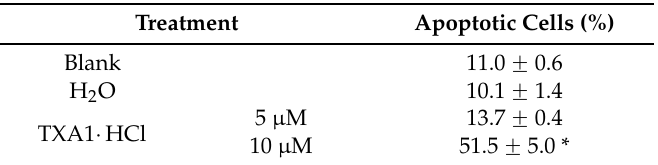
Table 3. Levels of apoptosis in MCF-7 cells following treatment with TXA1 ¨ HCl